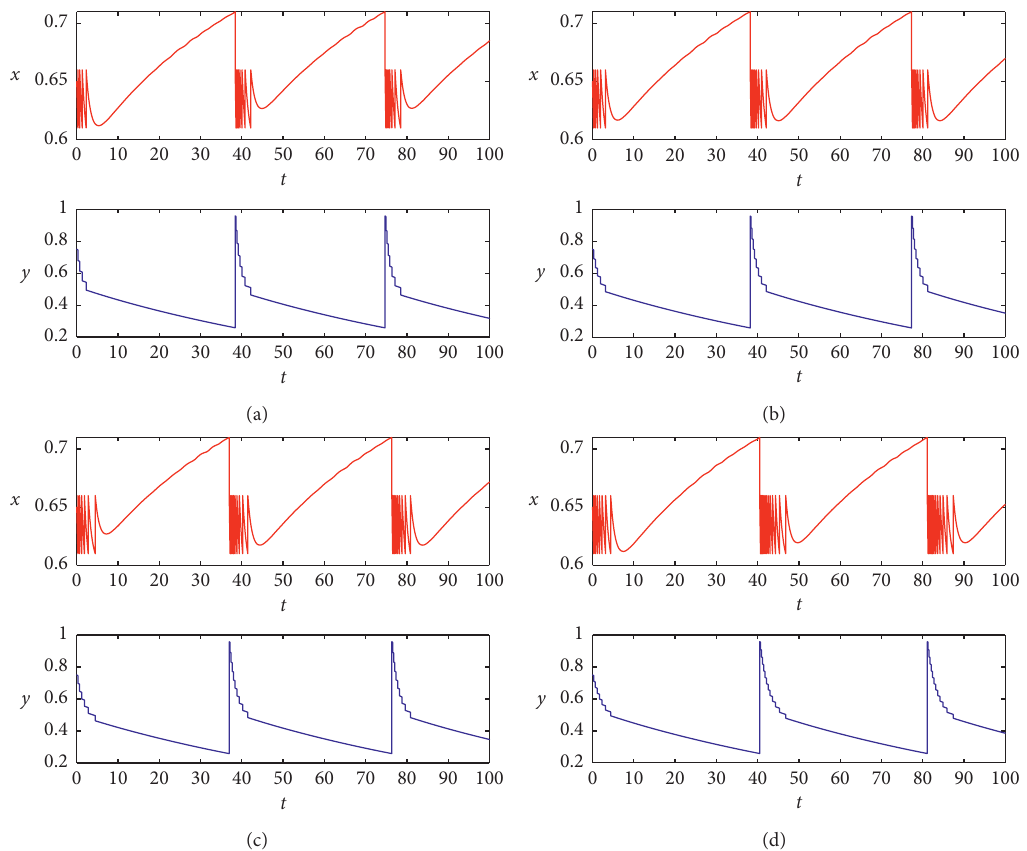
Figure 18: Change of the order of periodic orbits of system (12) for p ∈ [0.9, 0.95]: (a) order-8 periodic orbit at p � 0.9; (b) order-9 periodic orbit at p � 0.92; (c) order-10 periodic orbit at p � 0.93; (d) order-13 periodic orbit at p �